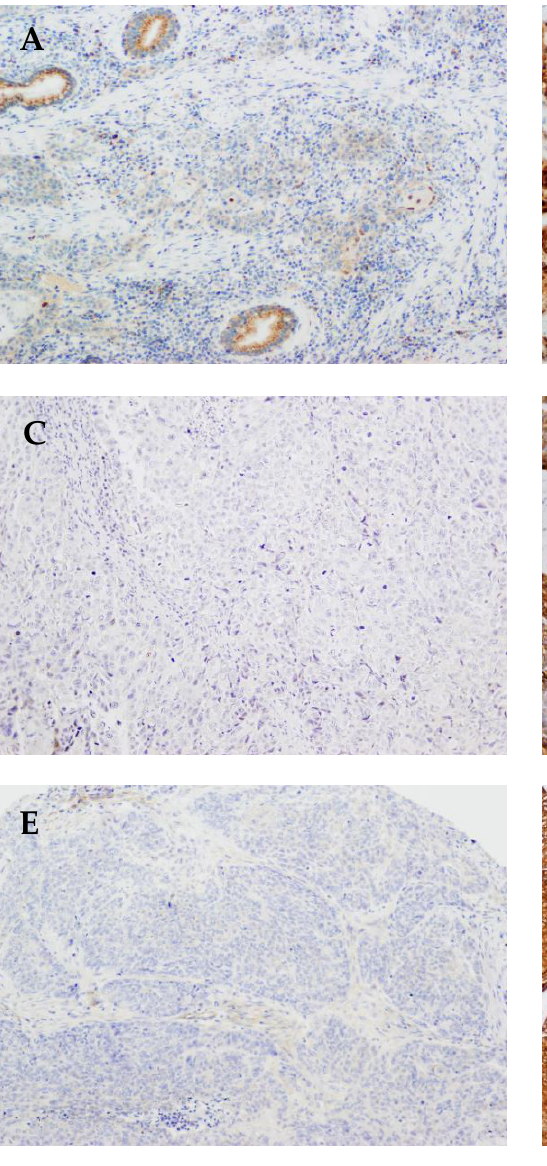
Figure 2. Representative examples of negative and strong positive staining for CCND1 ( A , B ), ANO1 ( C , D ), and CTTN ( E , F ). Original magnification ×20. Table 2. Analysis of CCND1, ANO1 , and CTTN gene gain and amplification in relation to HPV status in 88 HNSCC patients.